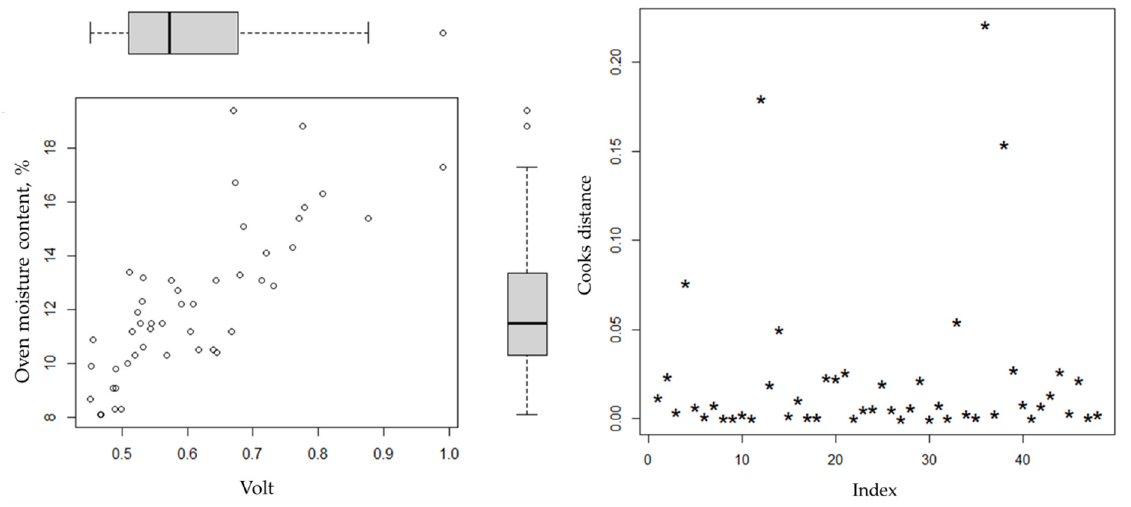
Figure 3. Outliers’ identification with the R software boxplot and Cooks distance method. The outliers were the F2, Q2 and Q4